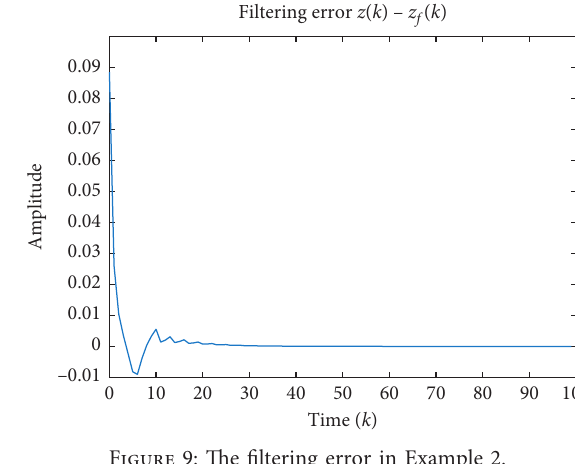
Figure 6: The filtering error in Case 2.